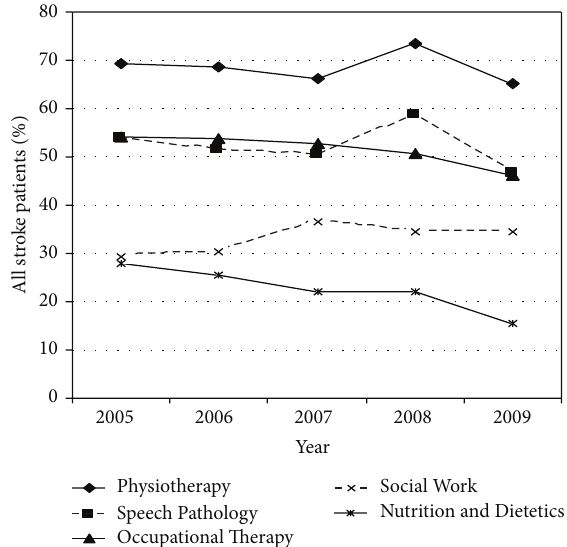
Figure 3: Percentage of all stroke patients who received care from allied health